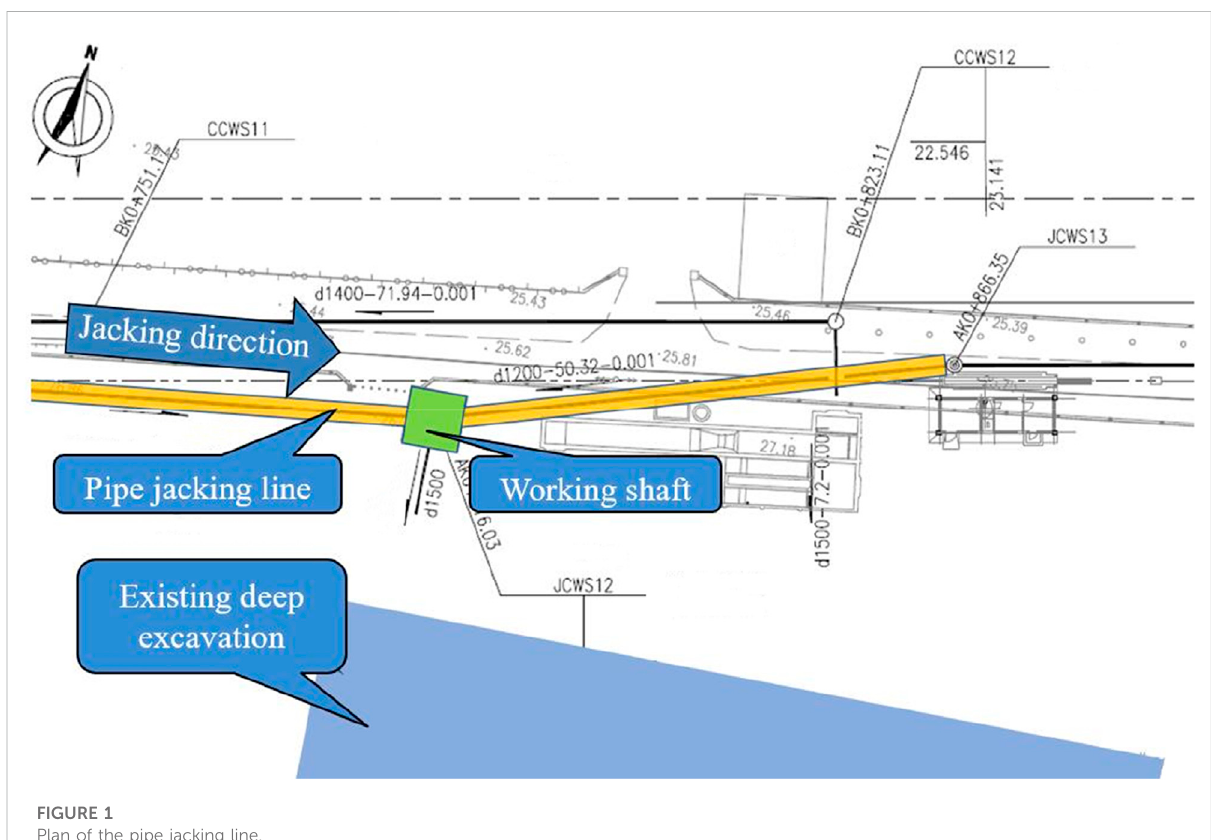
FIGURE 1 Plan of the pipe jacking